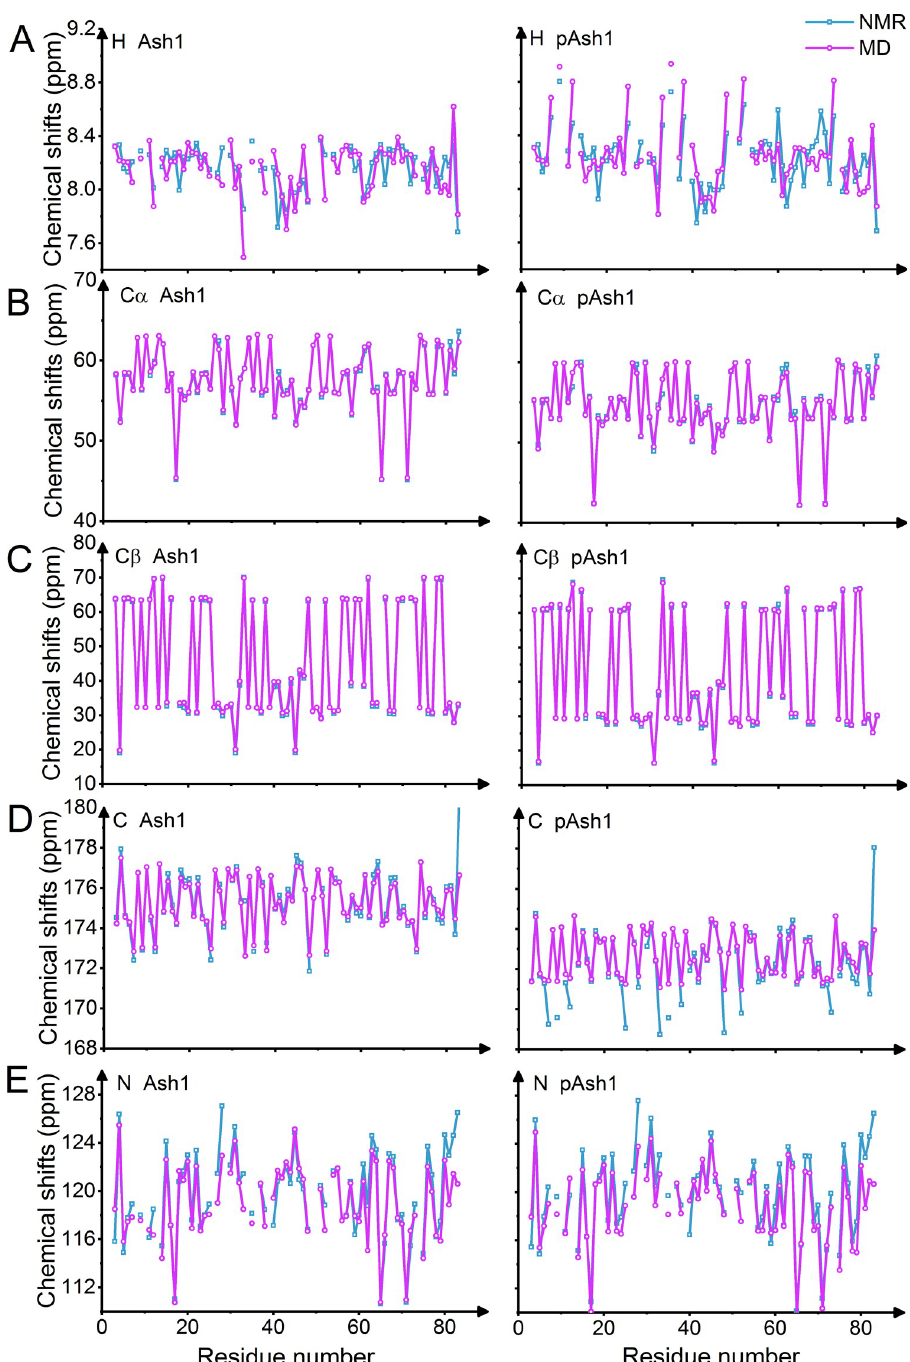
Fig 3. Validation of MD simulations by comparisons to NMR data. Comparisons of simulation-derived (purple, 350 mM NaCl) and experimental chemical shifts (cyan, 150 mM NaCl) for unphosphorylated (left panel) and phosphorylated (right panel) forms of Ash1 show very good agreement. Note that the experimental values for some residues were not available. Chemical shifts are for the atoms: A H, B C α , C C β , D C, E N. Experimental data from REF